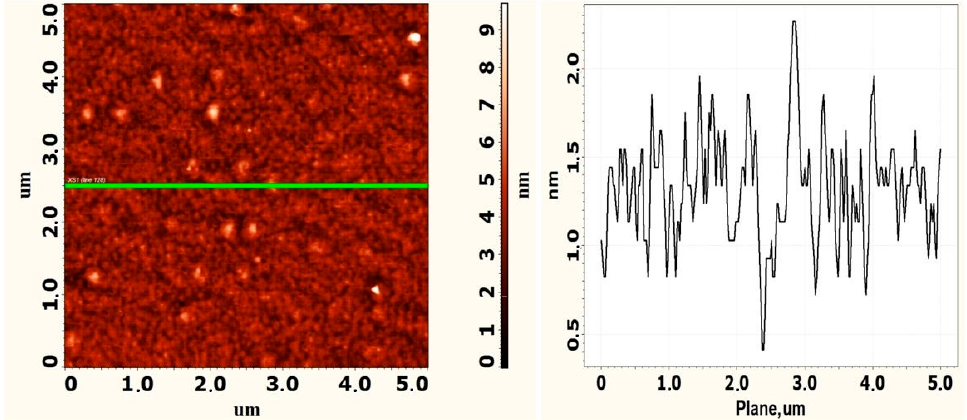
Figure 9. AFM image and profile of the CaF 2 film surface not exposed to radiation.